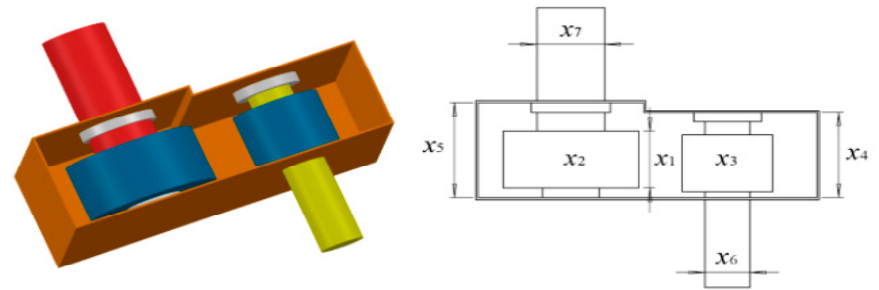
Figure 9. Model of speed reducer design.